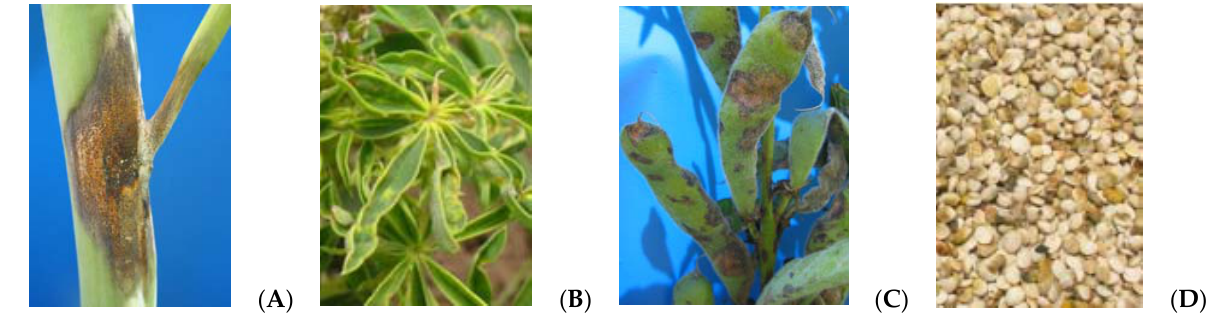
Figure 1. Characteristic symptoms of anthracnose on lupin stems ( A ), leaves ( B ), pods ( C ), and seeds ( D ). Table 2. Main foliar fungal diseases of lupin ( L. mutabilis ) in the Andean